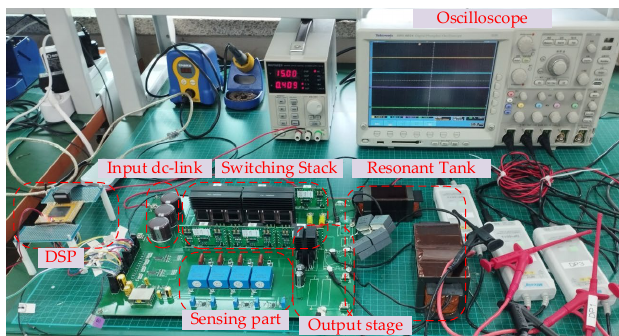
Figure 18. Prototype circuit of the proposed converter.